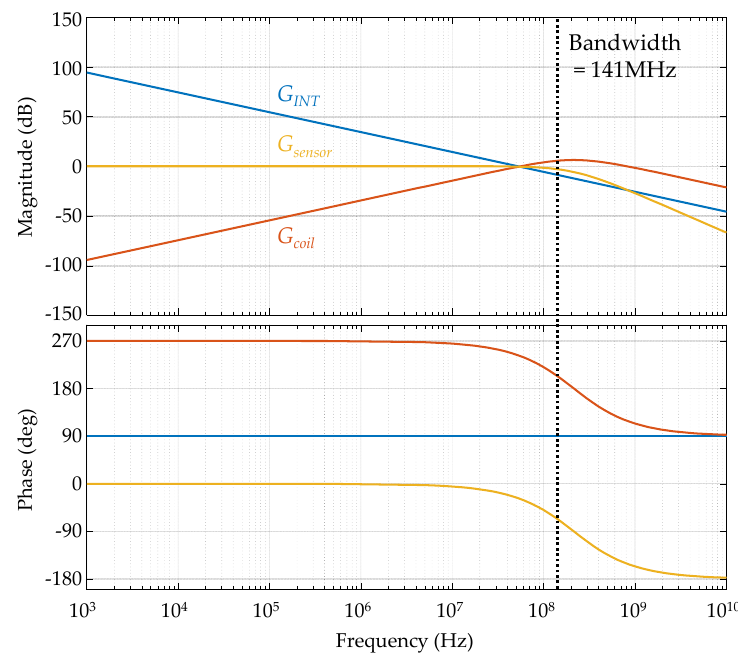
Figure 14. Magnitude and phase plot of the current-to-sensor output transfer function.